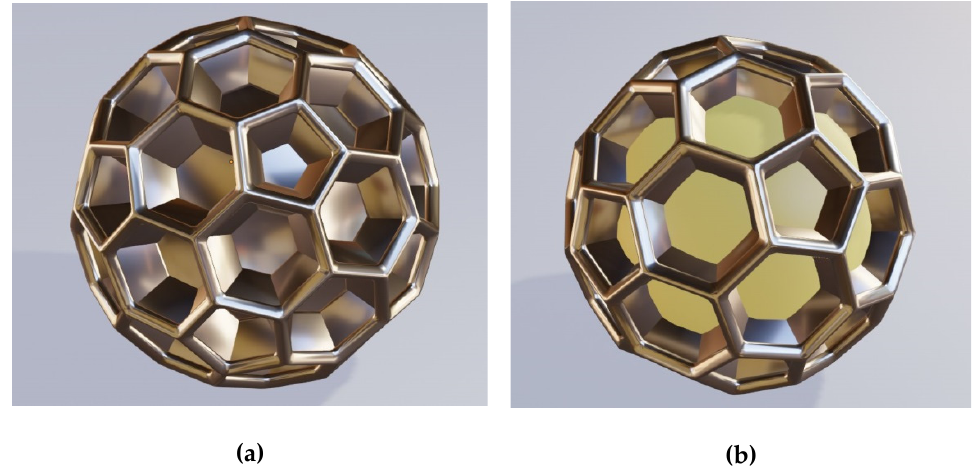
Figure 1. Fullerene-like honeycombed metallic structures miming the most common type of biological brochosomes. ( a ) Metal shell of buckyball-type honeycombed core shell; the core is dielectric (may be air); ( b ) Metal walls of buckyball-type honeycomb; no metal bottom is present at the bottoms of the honeycomb cells and the dielectric core is visible.